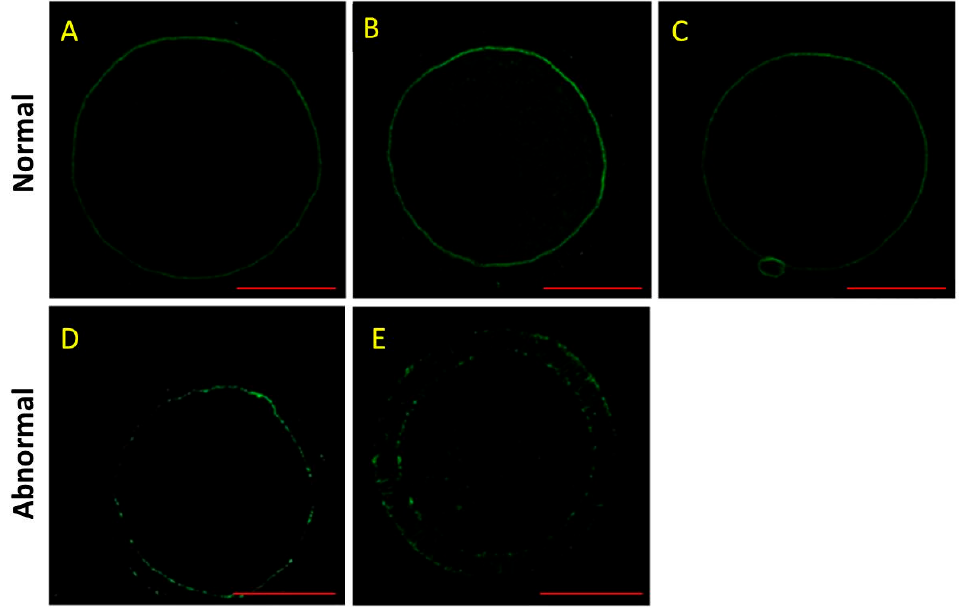
Figure 2. Effect of heat stress (HS) and melatonin on the normal rate of F-actin in the porcine oocytes during in vitro maturation (IVM). F-actin is stained using phalloidin (green). ( A – C ) are the representative images of normal F-actin in the porcine oocytes during IVM at 4, 18 and 42 h, respectively. ( D,E ) are the representative images of abnormal F-actin in porcine oocytes during IVM. Bar = 50. Table 4. Normal rate of F-actin